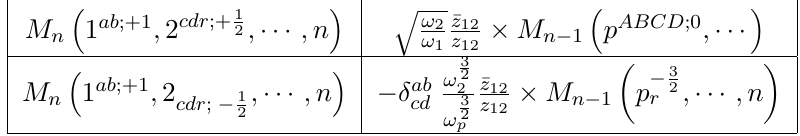
Table 12 . Amplitude corresponding to collinear graviphoton and graviphotino.